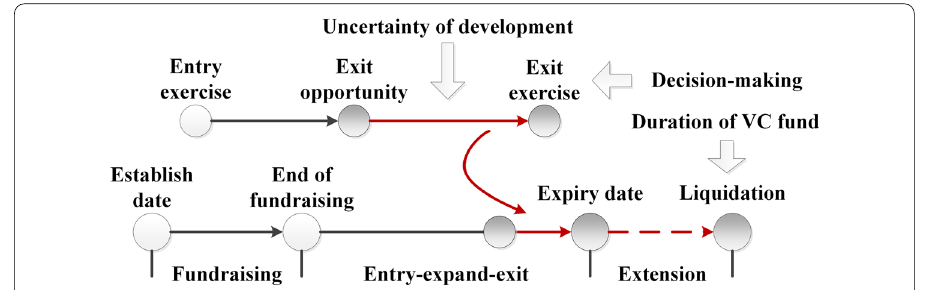
Fig. 1 The exit decision of VC and its embedding in the duration of VC